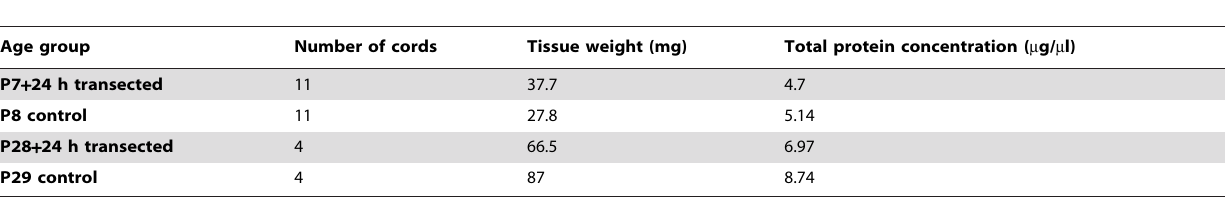
Table 1. Number, tissue weight and protein concentration of spinal cord tissue used for proteomic analysis in this study.